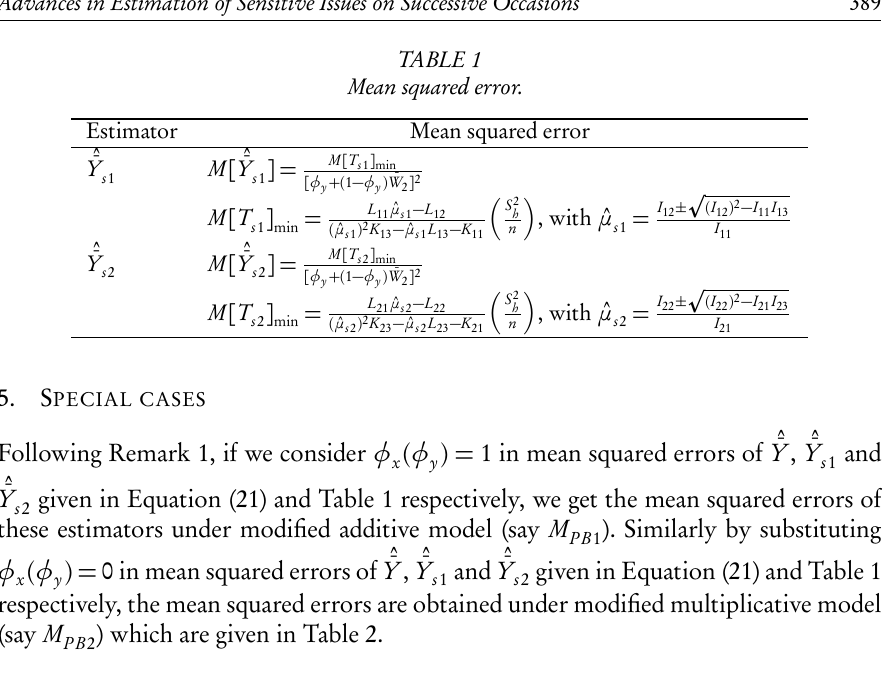
ˆ¯ ˆ¯ ˆ¯ Y , Y and Y under M s 1 s 2